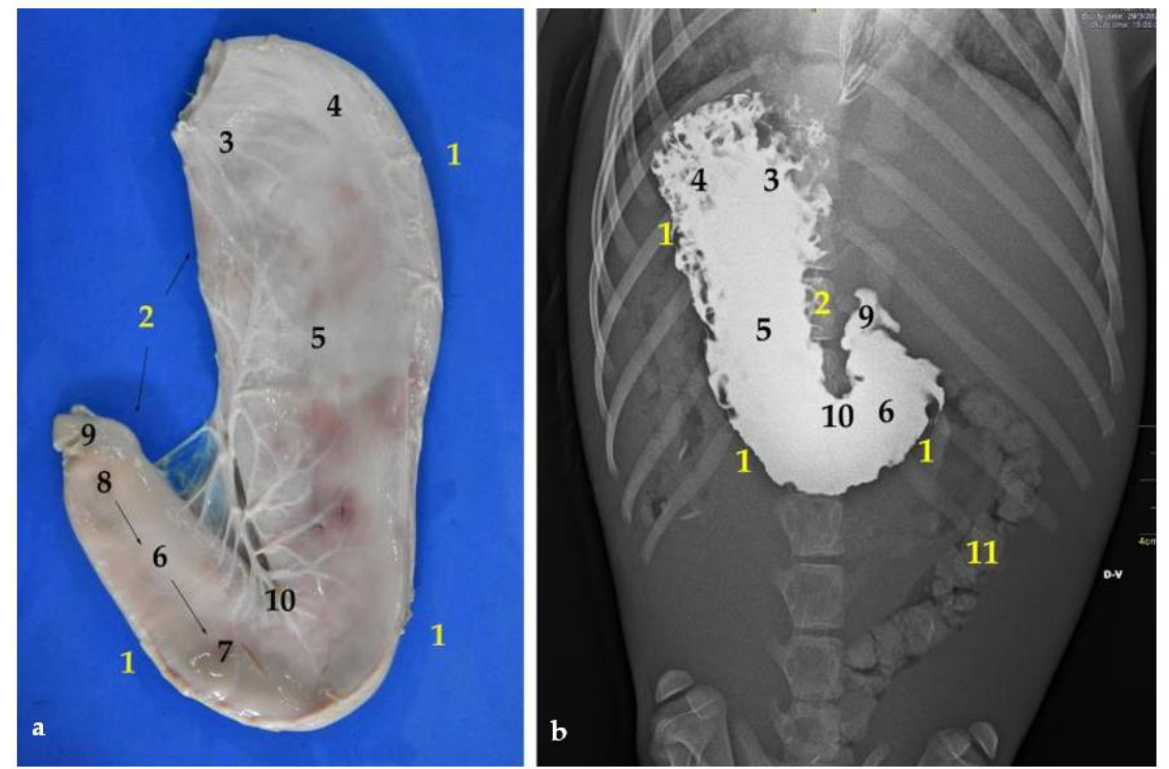
Figure 8. ( a ) Ventral view of the stomach; ( b ) dorsoventral contrast radiography. ( 1 ) Major curvature; ( 2 ) minor curvature; ( 3 ) cardiac part; ( 4 ) fundus; ( 5 ) body ( 6 ) right or pyloric part; ( 7 ) antrum pylorus; ( 8 ) pyloric canal; ( 9 ) pylorus; ( 10 ) angular incisure or angular notch; ( 11 ) colon.